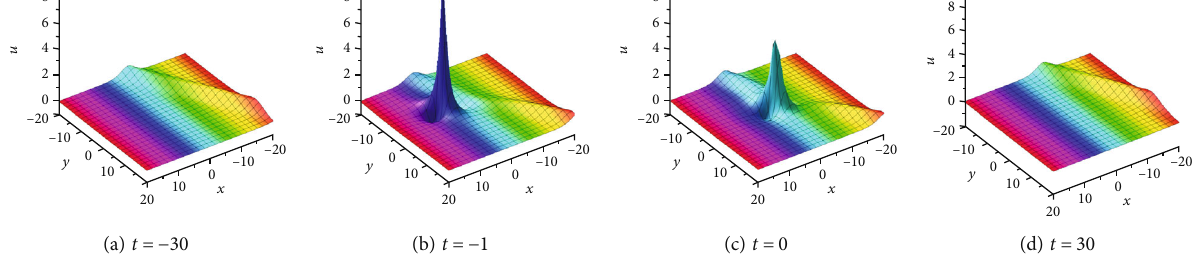
= 1, p = 3/2, k = 3/2, p = 1, and η ð 0 Þ 3 4 3 4